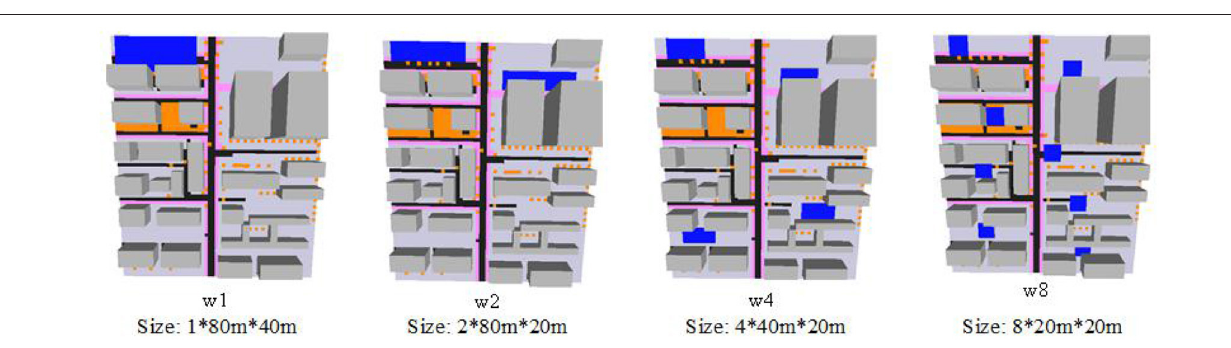
FIGURE 6 | Different layouts of water bodies in Chigang